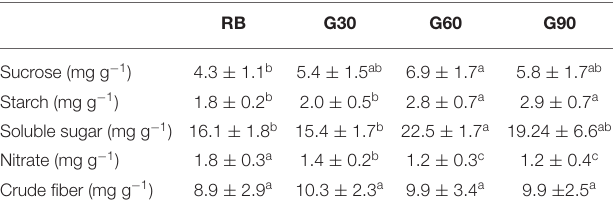
TABLE 3 | The accumulation of carbohydrate and nutritional quality as affected by different relative amount of green